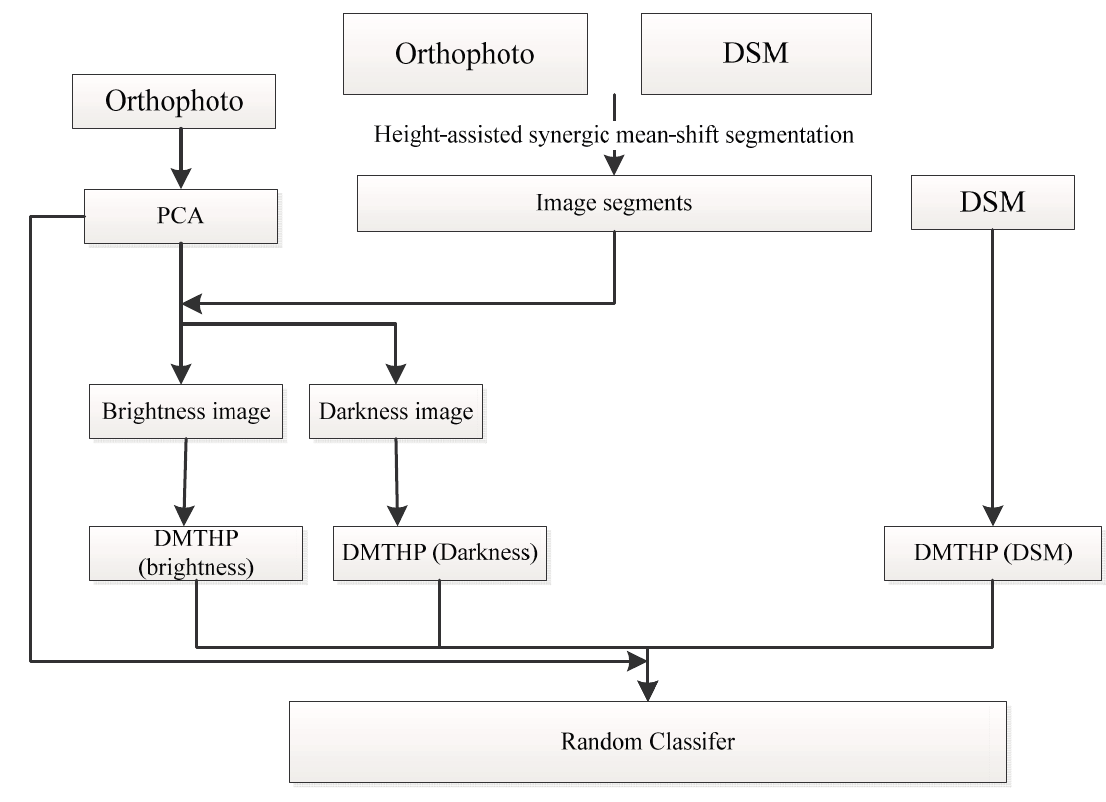
Figure 4. The proposed workflow for UHR image land cover classification. DMTHP, dual morphology top-hat